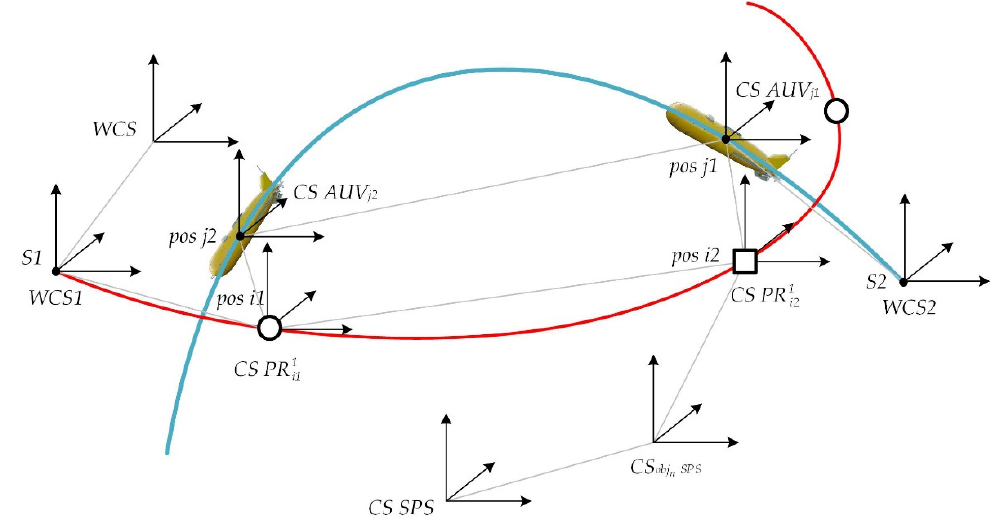
Figure 2. Used coordinate systems: WCS —world coordinate system (external CS); WCS1 —CS of AUV at the start position of the survey/initial trajectory (trajectory 1); WCS2 —CS of AUV at the start position of the inspection/working trajectory (trajectory 2); CS AUV j 1 —CS of AUV at position j 1 of the inspection trajectory; CS AUV j 2 —CS of AUV at position j 2 of the inspection trajectory; CS PR 1 —CS of the first type reference point of virtual of network VCRN on the survey trajectory at position i 1; CS PR 2 —CS of the second type reference point of virtual network VCRN on the survey trajectory at position i 2. Relationships between coordinate systems are indicated by dashed